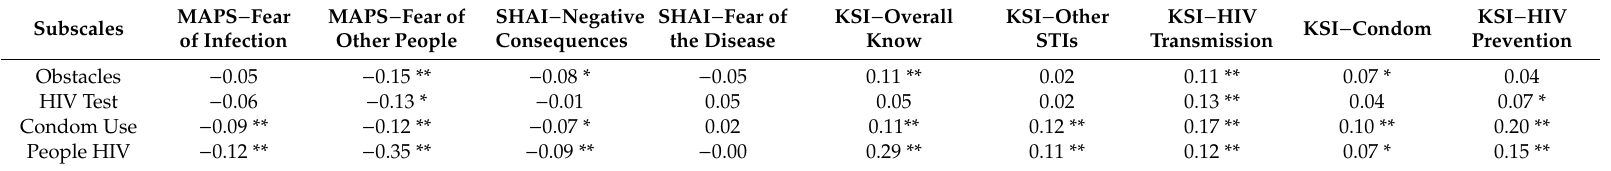
Table 5. Matrix of correlations among factors in the HIV-AS test and other similar